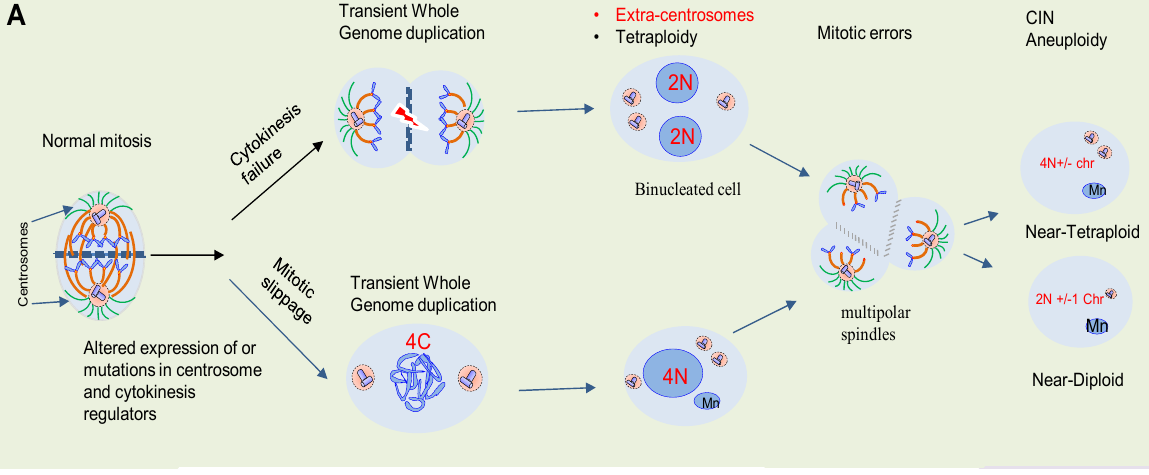
Figure 1. The route to aneuploidy and its link to centrosome dysfunction. ( A ) Aneuploidy is caused by errors in chromosome partitioning during mitosis. Changes include whole chromosomes (numerical aneuploidy) often caused by altered expres- sion or mutations in centrosome (i.e., CEP55) and cytokinesis (i.e., PRC1) regulators [8]. ( B ) Centrosome loss or structural changes in its components are early drivers of genomic instability causing both localized chromosome rearrangements and transient tetraploidy [18]. These alterations will generate intra-tumor heterogeneity and tumors containing a mix of cells with extra-numerical centrosomes or loss of its components. In general, little is known about the mechanisms of centrosome loss. However, centrosomes are normally inactivated or lost during specific developmental stages in different animals. Abbreviations: Chromosome, Chr; CIN; Chromosome instability. 3. Centrosome Biology and CIN In animal cells, the centrosome is the major microtubule-organizing center (MTOC) [8]. The core of the centrosome consists of centrioles of nine microtubule (MT) triplets embed- ded in an ordered and protein-rich matrix called pericentriolar material (PCM). Centro- somes promote the production of bipolar mitotic spindles and supply a matrix of primary cilia in various cell types (Figure 2A) [21,22]. In addition to these structural functions, centrosomes and primary cilia have also evolved into essential signaling hubs to build and regulate the sensory/motor characters of metazoans [23,24]. It is increasingly recognized that centrosome is an organizing unit not only for MTs, but also for actin, Golgi apparatus, and signaling molecules coordinating cell migration, cell polarity, and fundamental signal transduction pathways [25,26]. Large-scale proteomic studies have revealed that there are more than 400 centrosome-associated proteins (about 3% of human proteome, but the exact functions of most of these proteins are still unknown and require further investi- gation. However, recent advances in imaging, proteomics, and structural biology have revealed new insights into how microtubule-associated proteins regulate the structure,